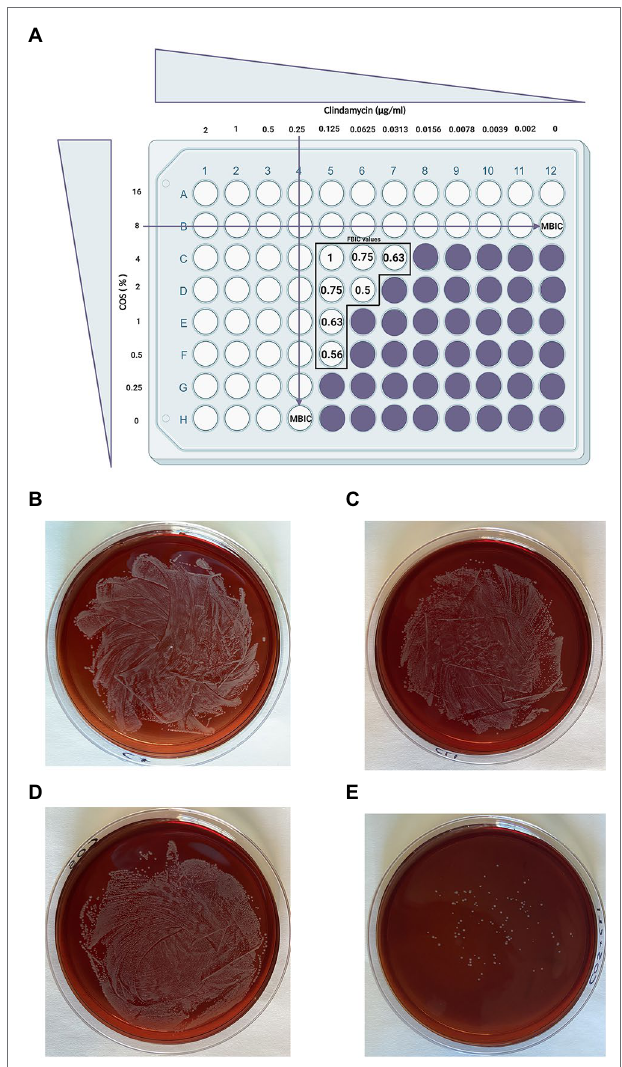
FIGURE 5 | A simulated checkerboard assay for the combination of COS with CLI against biofilm formation of S. aureus and the subsequent growth of the synergistic combination on blood agar plates. As depicted in ( A ; Pillai et al., 2005), both COS and CLI were 2-fold serial diluted starting from 16% COS (2 × MBIC) and 2 μ g/ml CLI (8 × MBIC). Wells without color refer to full inhibition of S. aureus biofilm formation ( ≥ 90% biofilm inhibition) while in purple wells the S. aureus biofilm formation was not fully inhibited. The FBIC values of the wells that showed synergistic or additive effect were calculated as described in the material and methods section using the following equation: